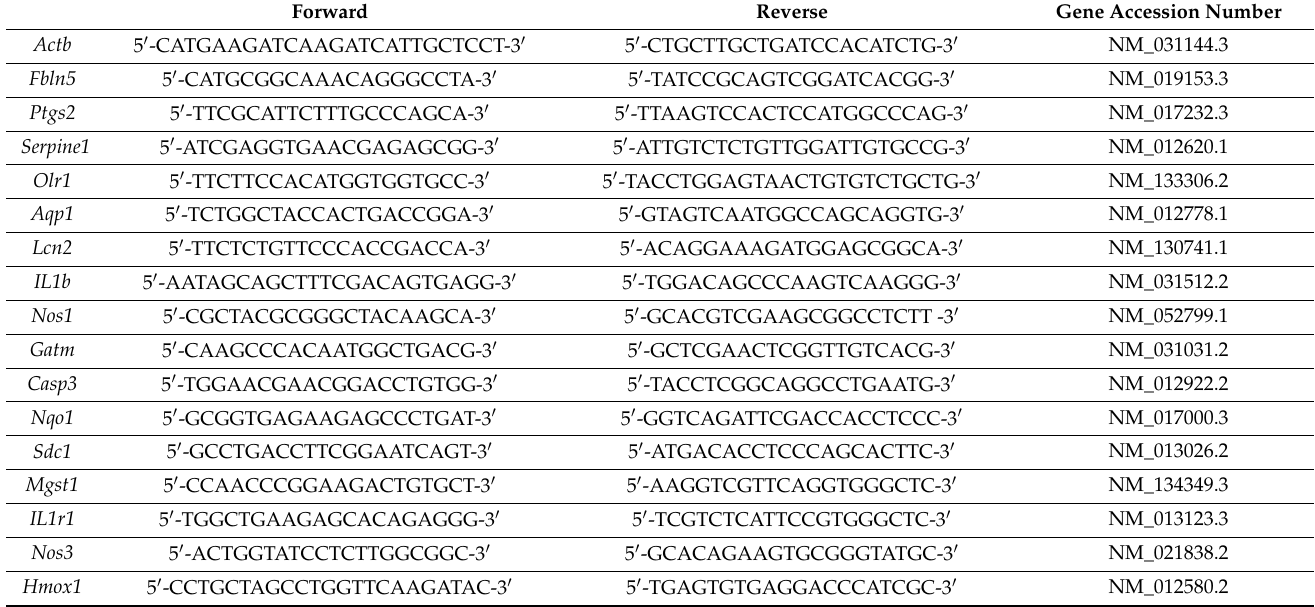
Table 1. Primer sequences for